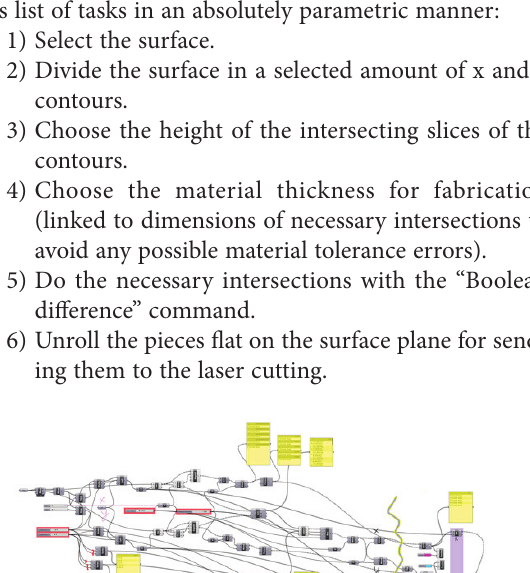
Figure 1. Construction planes are set on x-axis and y-axis to cut any complexity of surfaces into regular contours